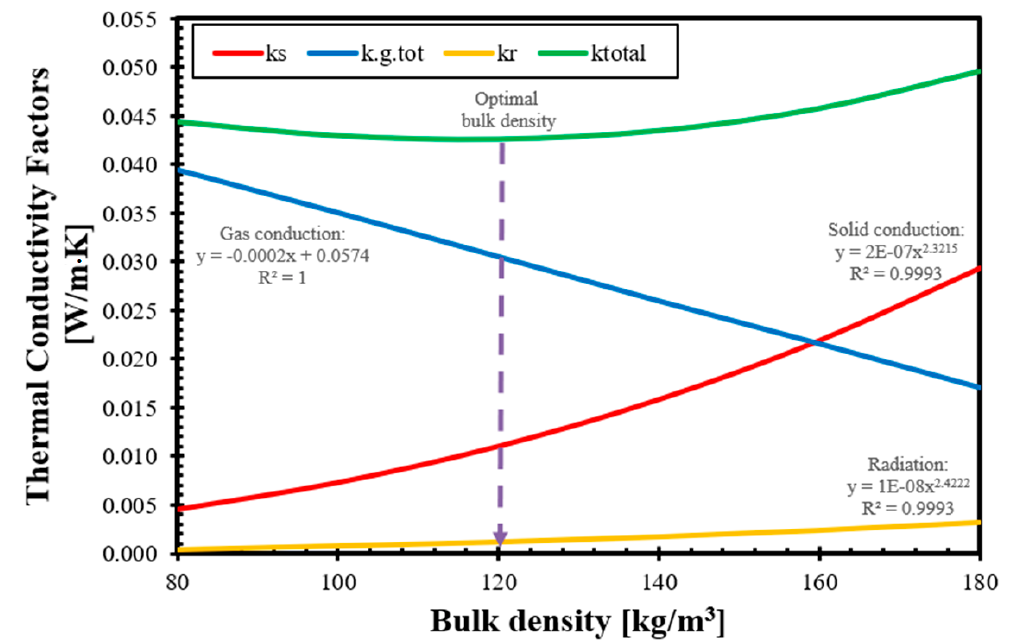
Figure 12. Thermal conductivity factors from the model in function of bulk density; Type-2 straw.